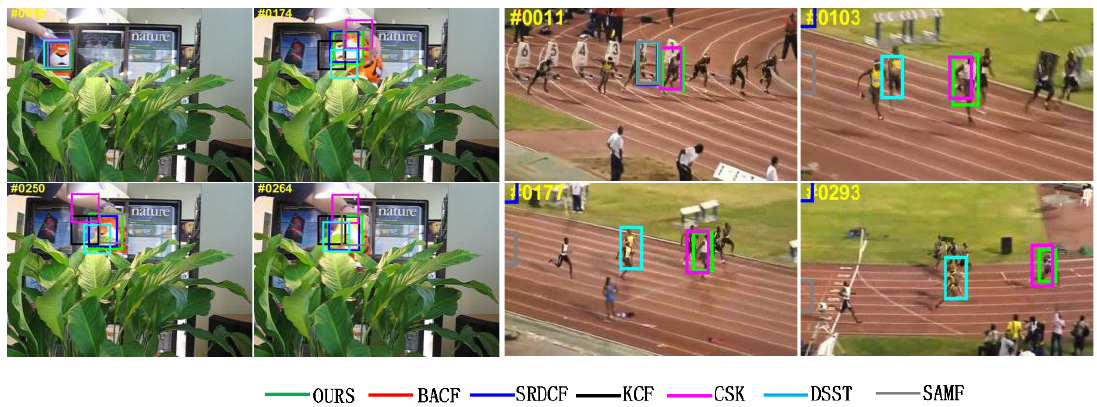
Figure 7. Tracking results of seven trackers on Tiger2 ( left ) and Bolt2 ( right ).